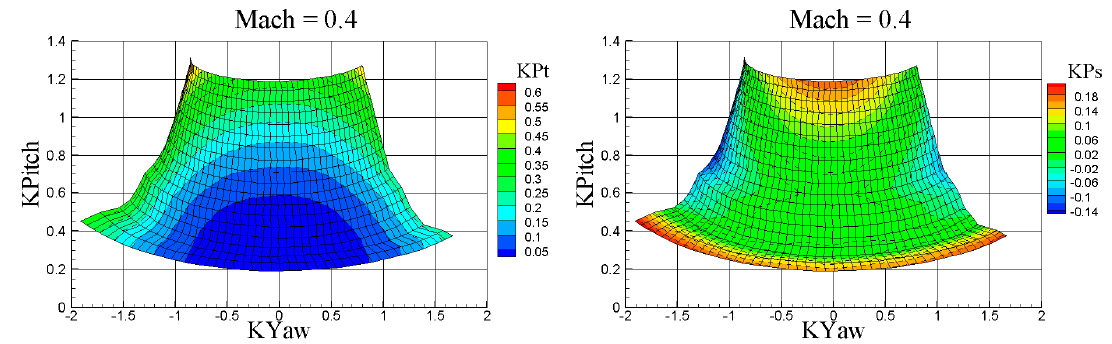
Figure 10. KPt and KPs on the KYaw and KPitch coefficient grid for sFRAPP (range ± 22°) for aerodynamic coefficients defined according to set A.